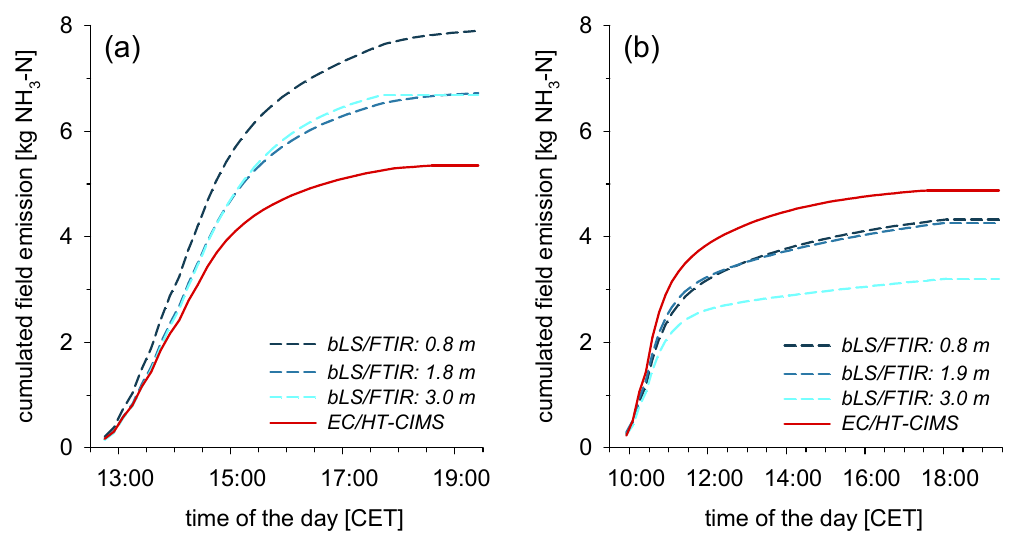
Fig. 8. Cumulative field emissions derived from EC/HT-CIMS and bLS/FTIR on (a) 4 August 2009 and (b) 6 August 2009.